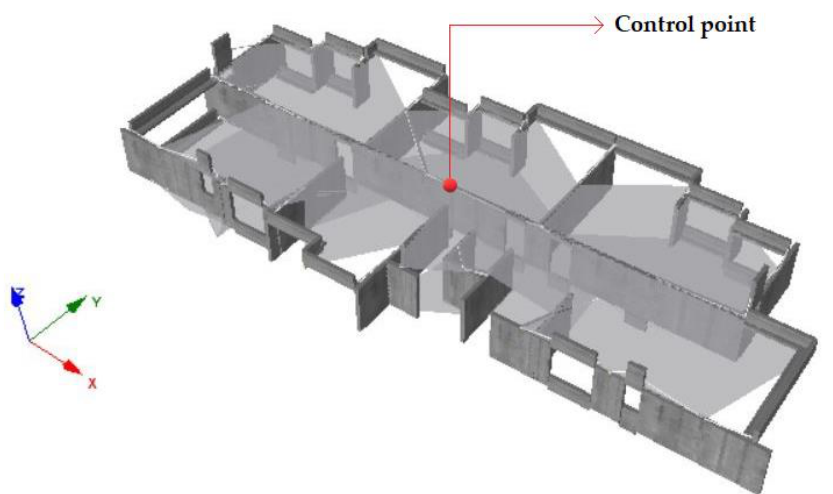
Figure 5. Example of displacement control point.